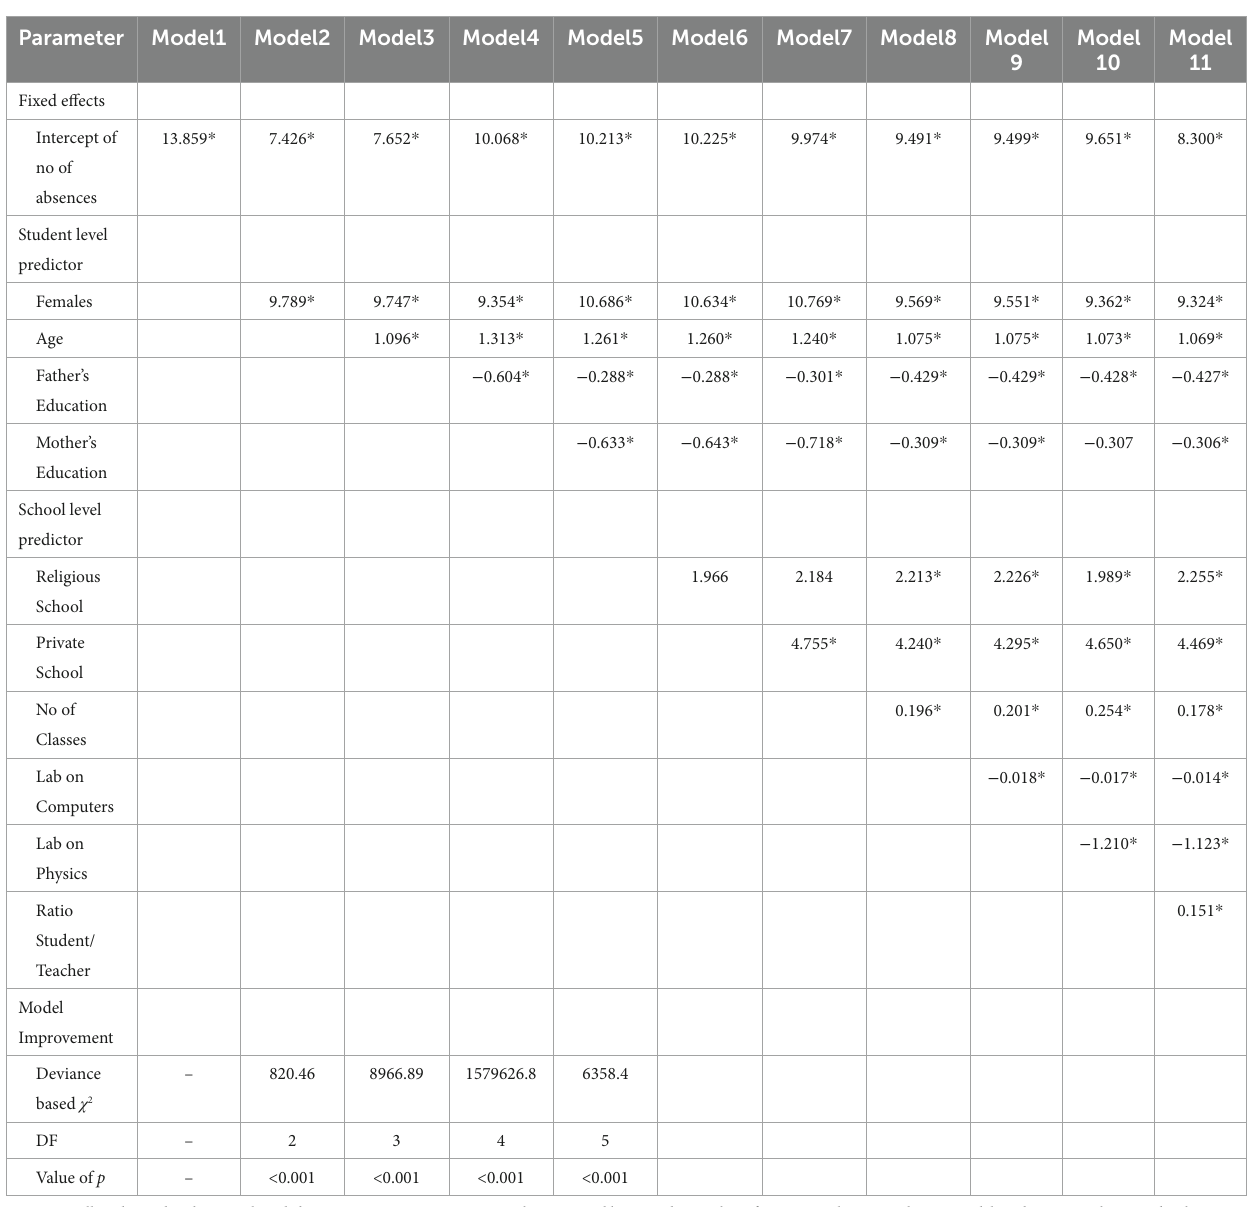
TABLE 4 Prediction of student number of absences from student level and school level